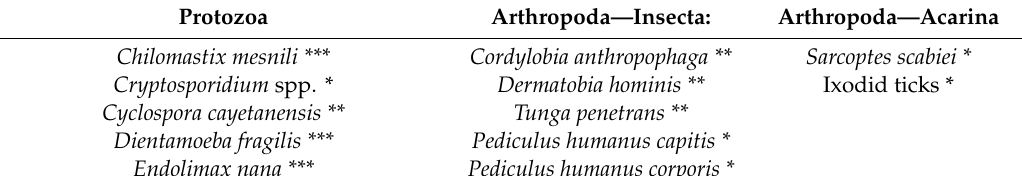
Table 2. Protozoa and Arthropoda diagnosed in